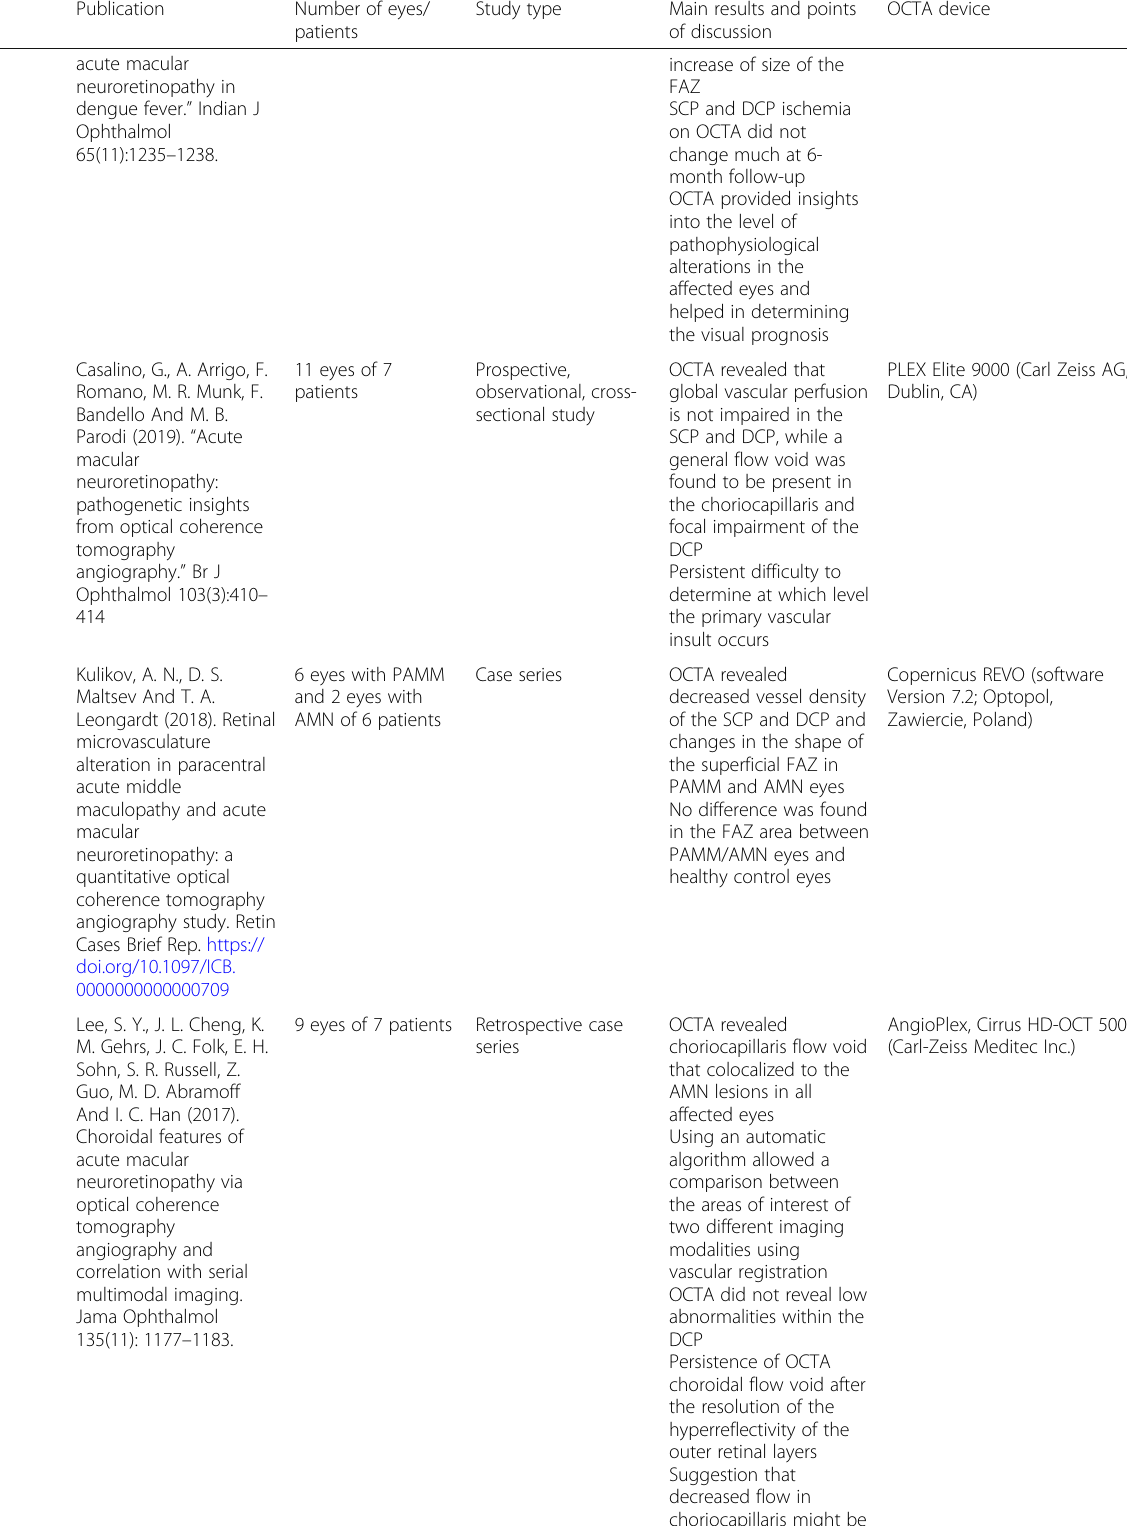
Table 1 Summary of publications on the implementation of OCTA in white dot syndromes (Continued) Disease